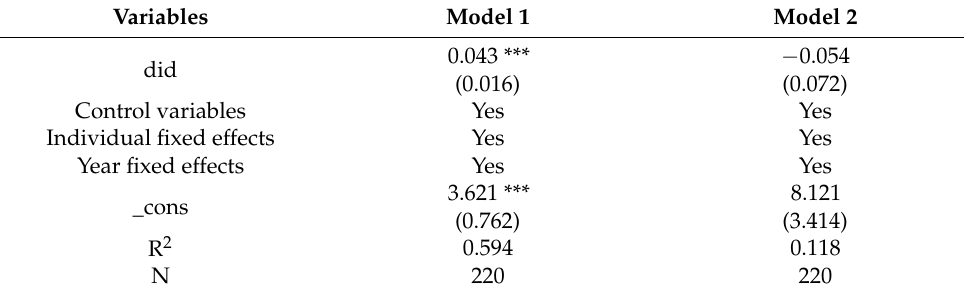
Table 6. Impact mechanism analysis.